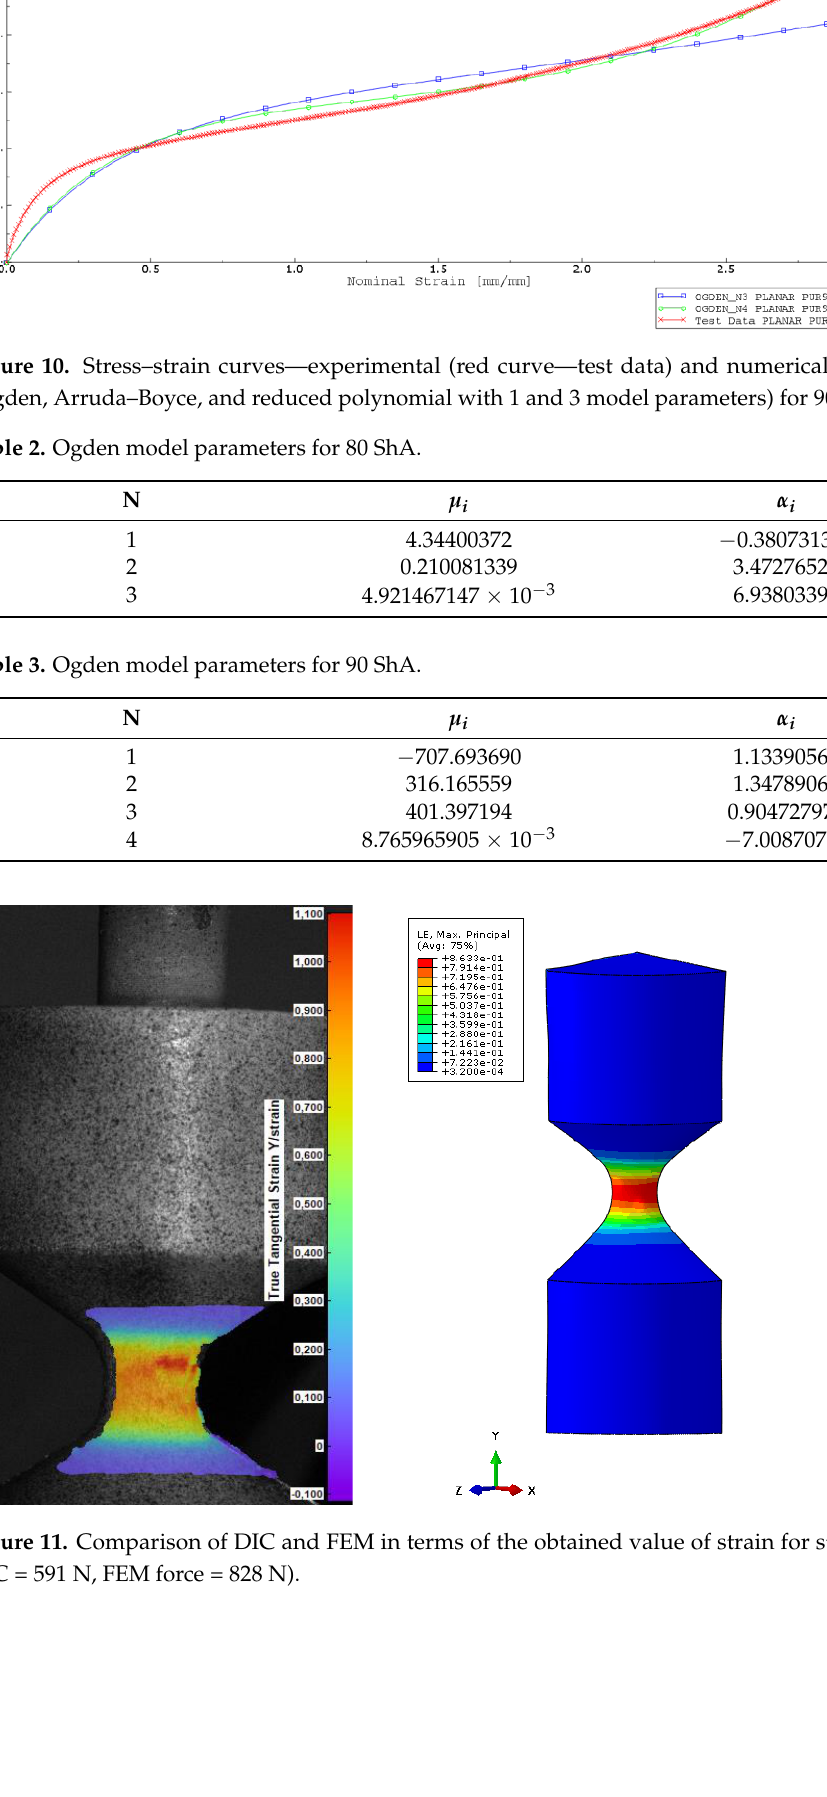
Figure 12. Comparison of DIC and FEM in terms of the obtained value of strain for step 30 (force DIC = 465 N, FEM force = 468 N).